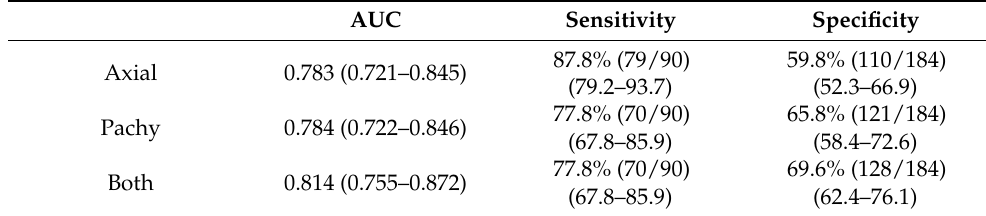
Table 2. Area under the curve (AUC), sensitivity, and specificity outcomes obtained by assessment using an axial map, a corneal pachymetry map, and a combination of the two, with or without respect to patients’